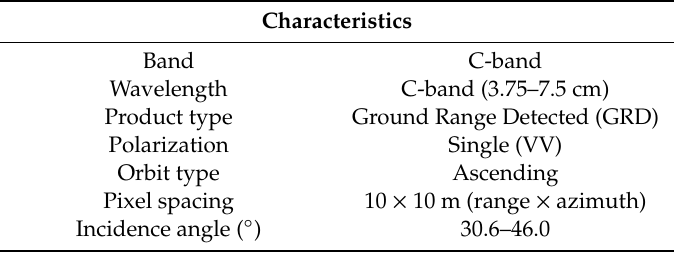
Table A1. Main characteristics of Sentinel-1A image.